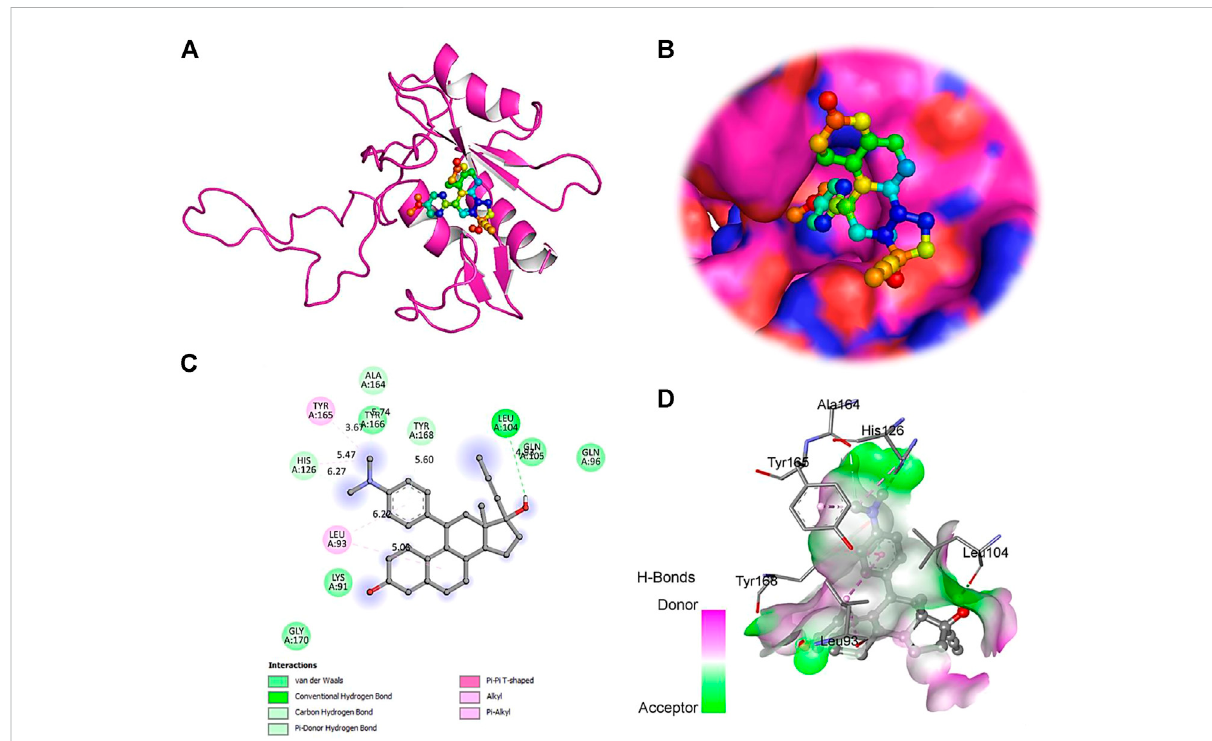
FIGURE 8 The crystal structure of SOCS3 in complex with Mifepristone. (A) - A cartoon representation of PTEN complex close view. (B) - Surface representation of PTEN in complex with Mifepristone is represented in sticks-boll form. (C) - A close view of substrate binding pocket representing the key amino acid residues forming interactions with inhibitor molecule. (D) - Surface representation of conserved substrate-binding pocket of